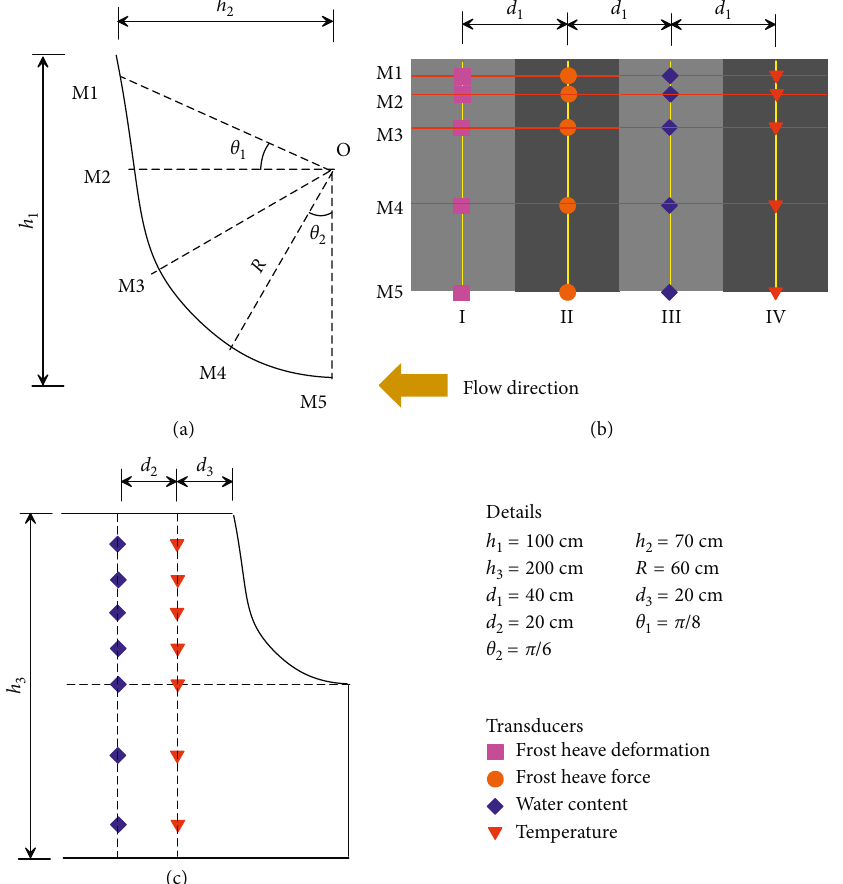
Figure 3: Specific layout of the transducers in the canal. (a) Five monitoring points in the lining structure. (b) Plan view. (c) Monitoring points in the canal bank.